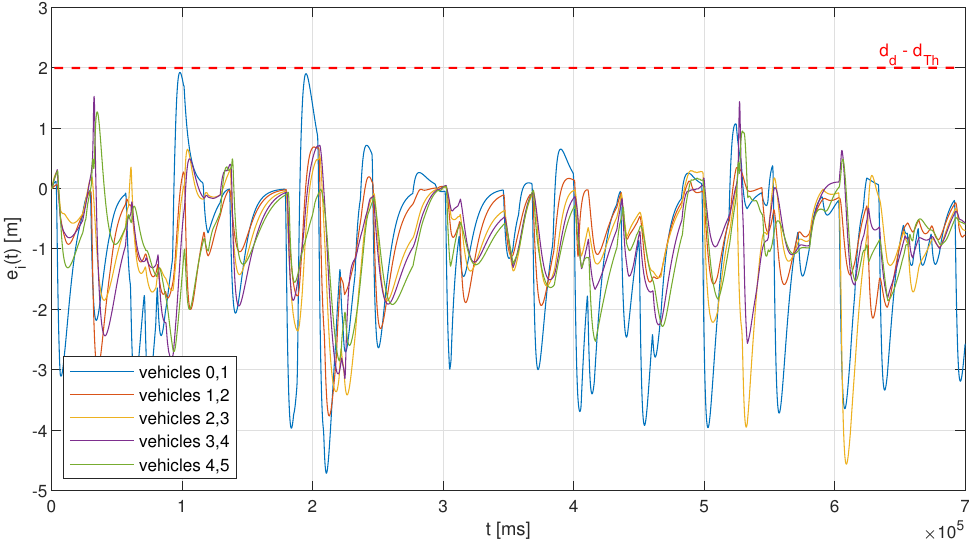
Figure 9. Example of inter-vehicle distance error evolution in a simulation run for adaptive periodic transmission; numbers in the legend represent vehicles’ positions in the platoon, with 0 indicating the leader, and 5 denoting the last vehicle (the tail of the